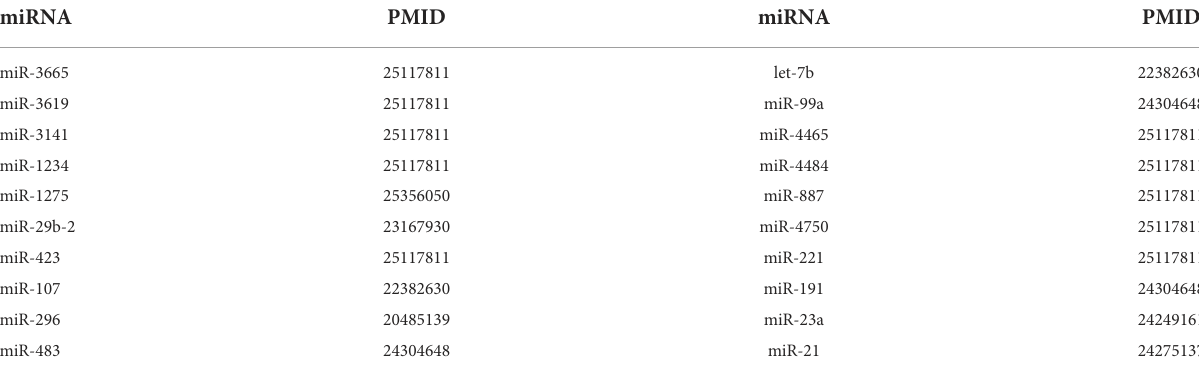
TABLE 3 The top 20 predicted miRNA related to 5-FU.